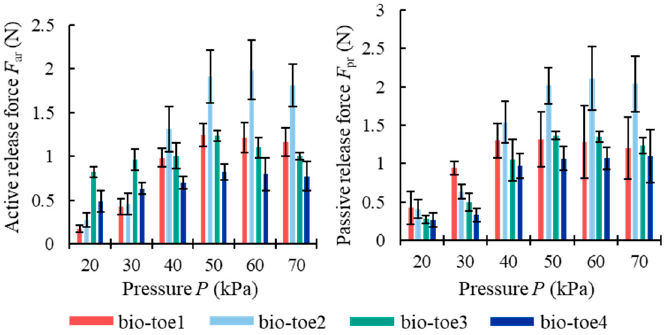
Figure 10. Active and passive release force of the four bio-toes.